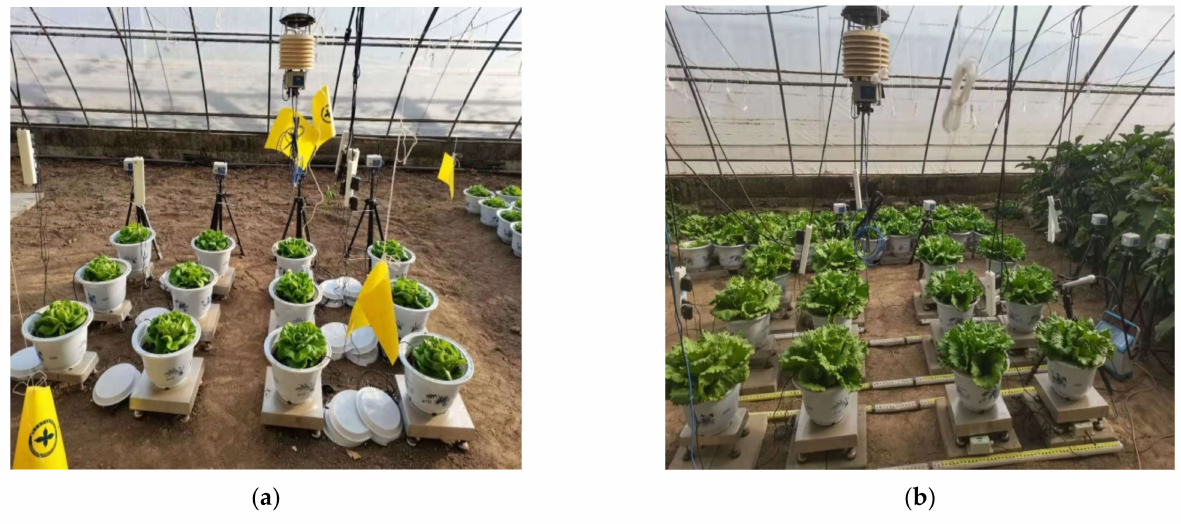
Figure 2. Test layout ( a ) first season, ( b ) second